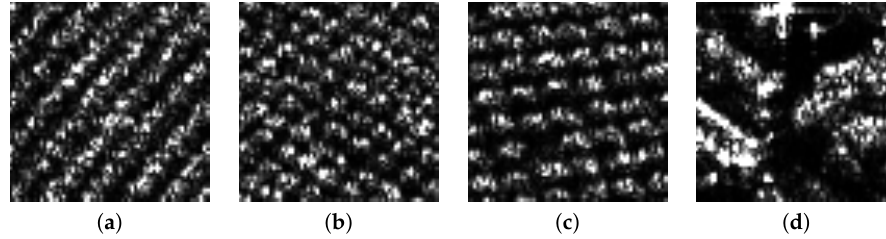
Figure 11. Representative examples with structural features in the Orchard dataset. ( a ) Mango2; ( b ) Mango3; ( c ) Longan; ( d )